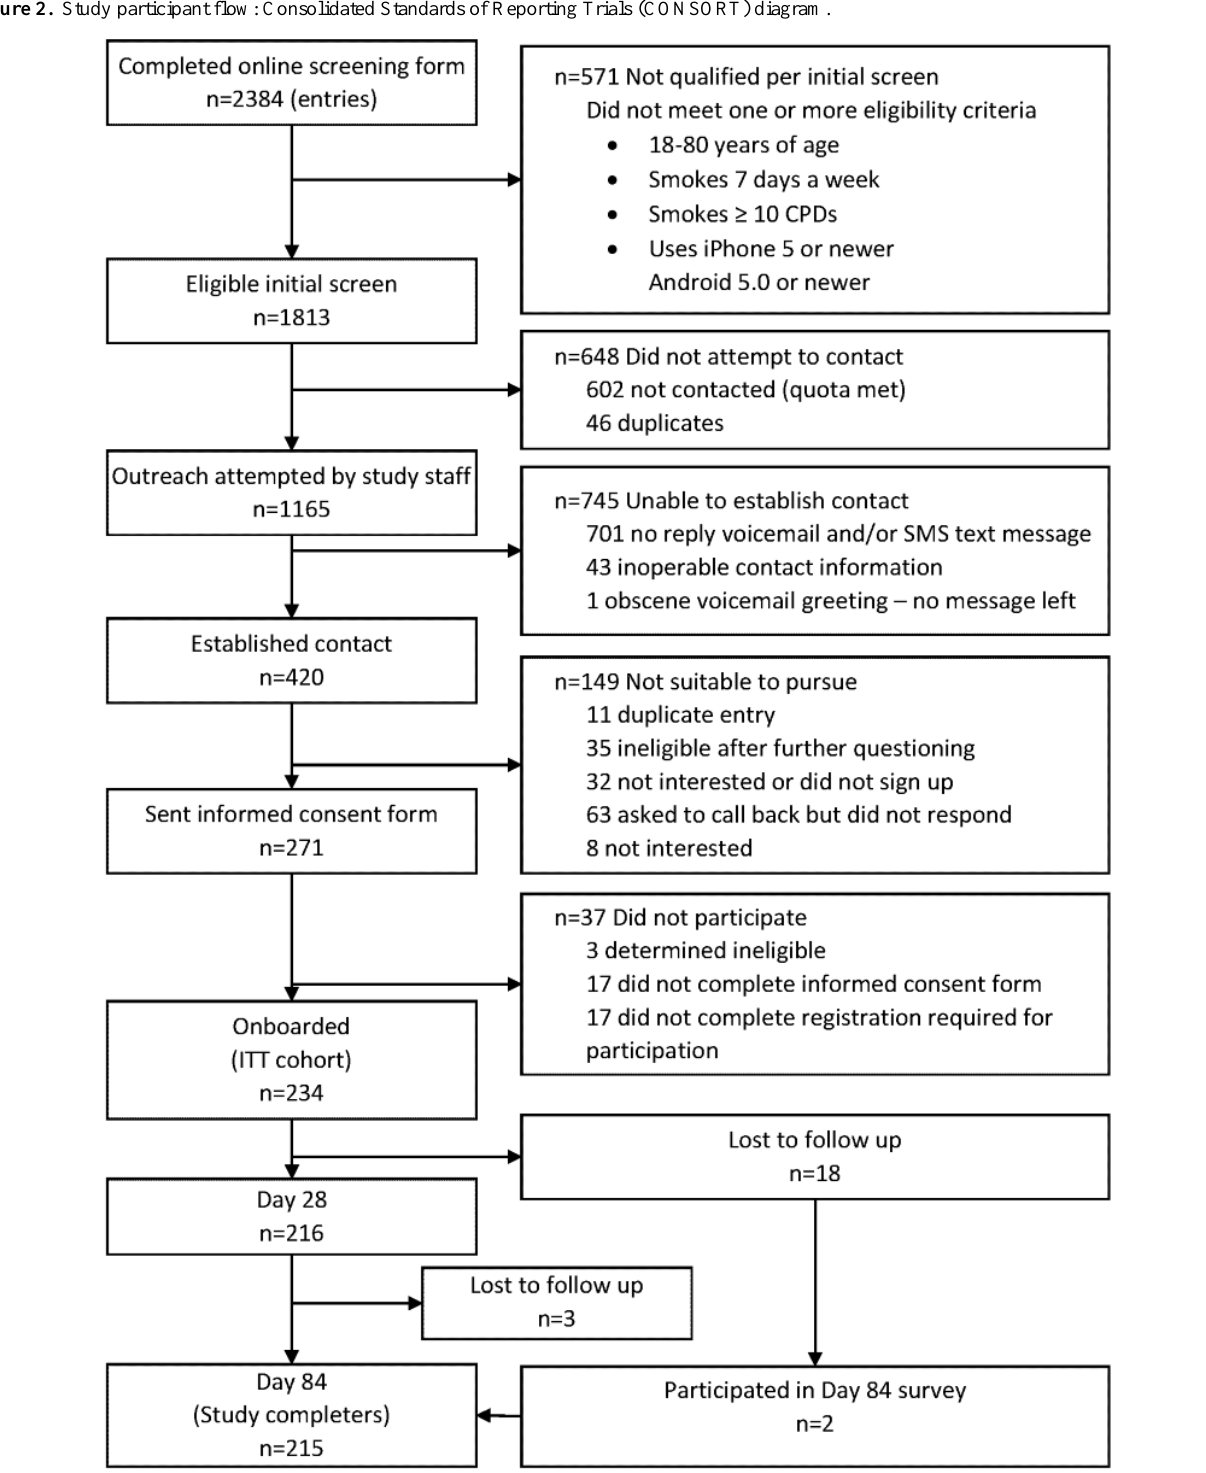
Figure 2. Study participant flow: Consolidated Standards of Reporting Trials (CONSORT)